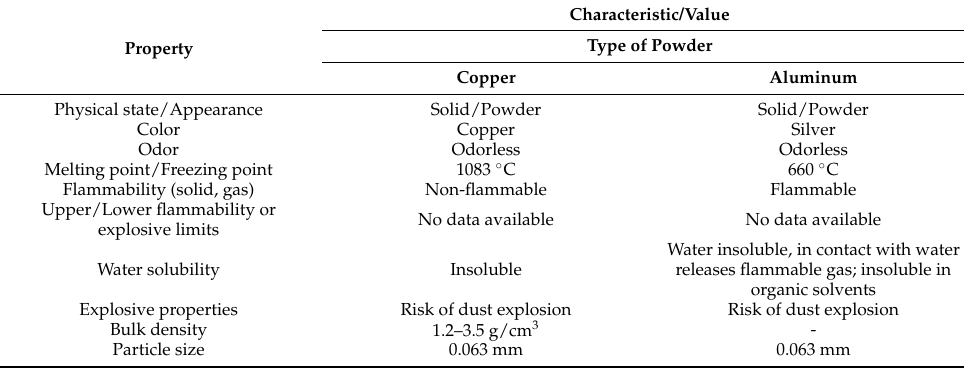
Table 5. Physical and chemical properties of copper and aluminum powders [38].